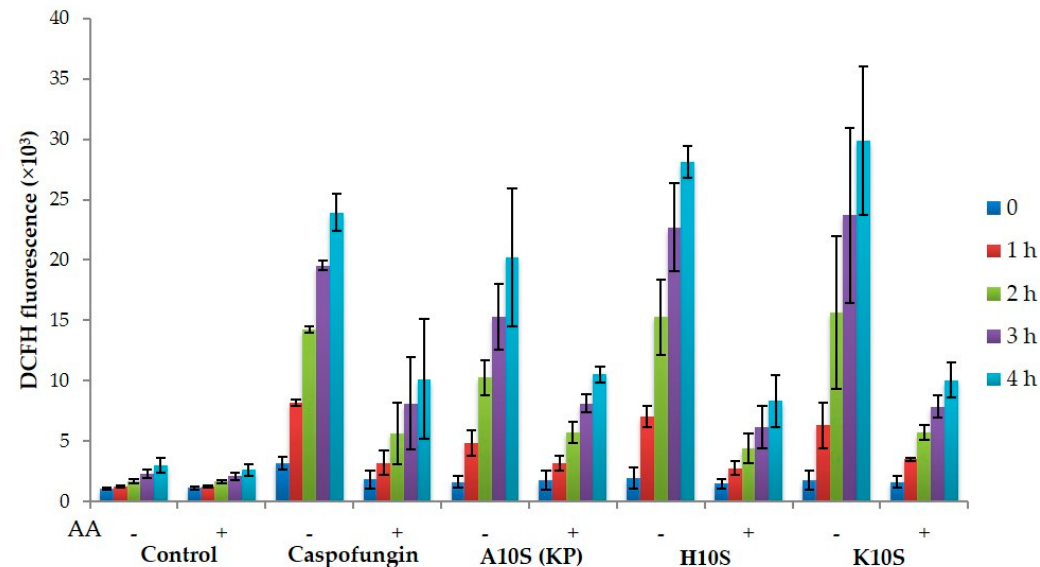
Figure 7. Intracellular ROS production induced by treatment with KP and selected KP-derivatives. After incubation with (+) or without ( − ) ascorbic acid (AA), Candida albicans SC5314 cells were treated for 30 min with caspofungin (CAS, 20 µ g/mL, positive control) and peptides KP, H10S, and K10S (20 × EC 50 ), then DCFH-DA was added and fluorescence intensity was monitored at different times. Data represent the mean ± standard deviation from at least two independent exper- iments.